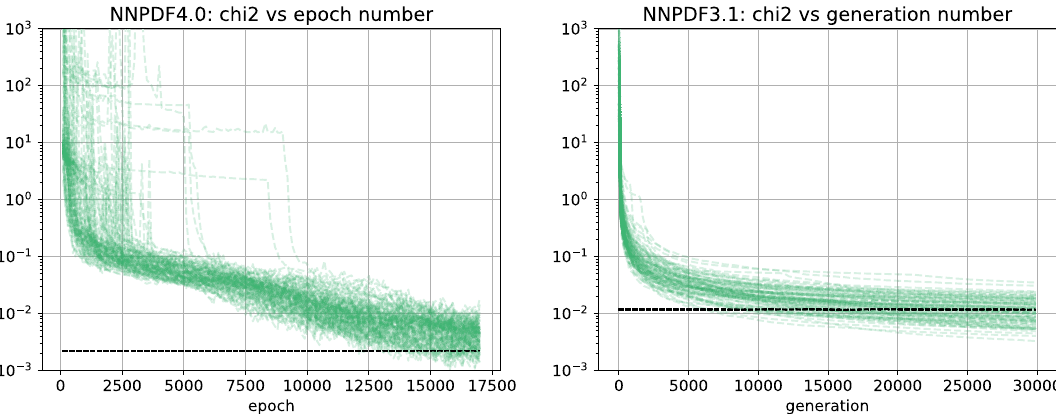
Fig. 7 χ 2 distribution across replicas as a function of the training epoch and genetic algorithm generation for the NNPDF4.0 (left) and NNPDF3.1 (right) methodology. The black dotted line in each plot represents the final χ 2 of the central value of the corresponding fit, equal to 0 . 002 and 0 . 012 respectively